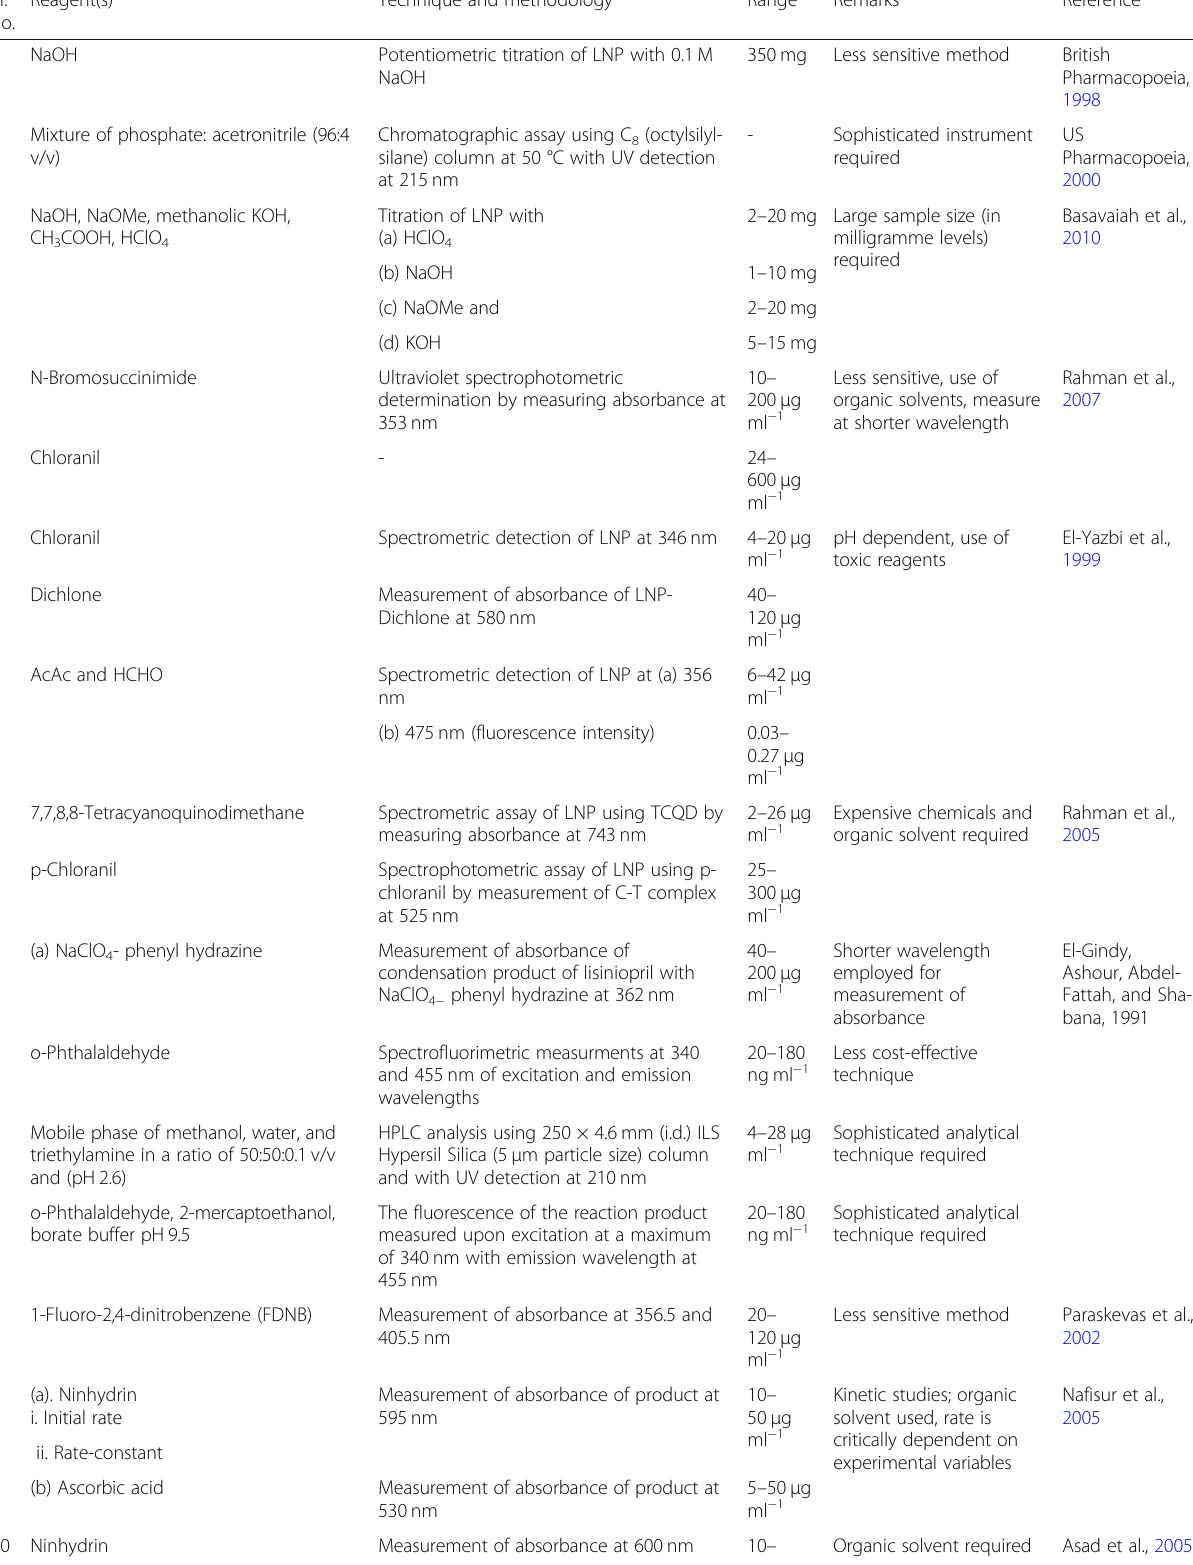
Table 1 Performance characteristics of existing methods of LNP Sl. no.